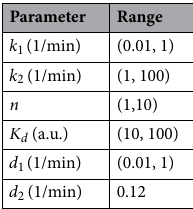
Table 1. Sampled intervals for each of the parameters of the problem.